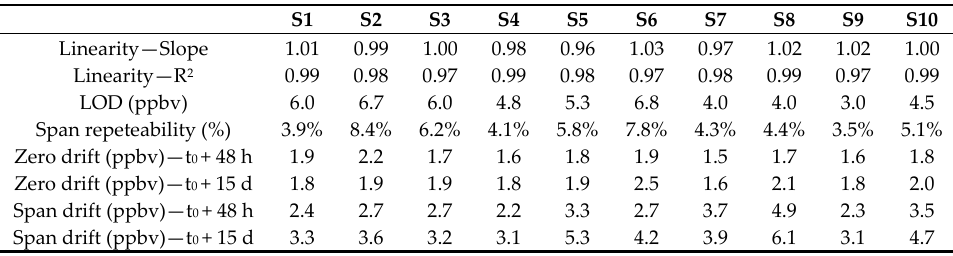
Table 1. Assessment of the accuracy and drift evaluation for 10 Cairsens NO 2 . Drifts are evaluated as the average of the absolute differences between consecutive pairs of measurements performed for the same concentration level and the same sensor.